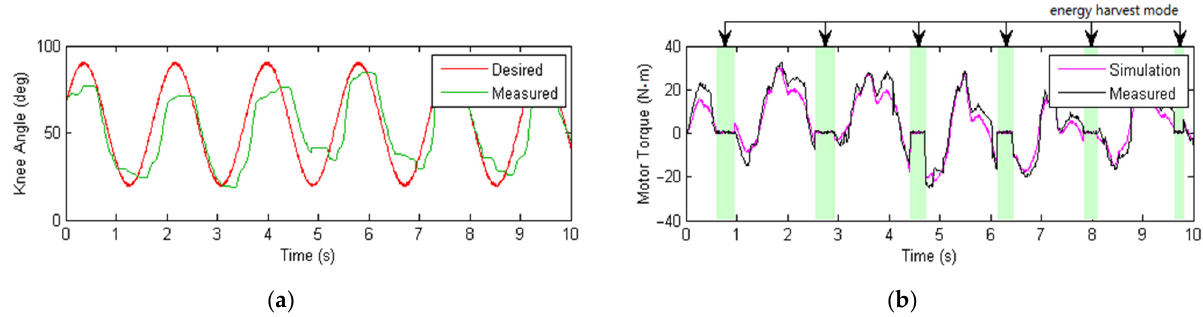
Figure 14. Plots of the measured tracking performance of the exoskeleton knee angle when the walking speed of the human subject was 1.2 km/h downstairs. ( a ) Measured and desired knee angular displacement during movement down stairs. ( b ) Measured motor output or assistance torque showing the mode switching operation of the exoskeleton system. The shaded regions in a light green color correspond to the time intervals of the energy harvest mode,and the remaining regions are for power assistance mode.